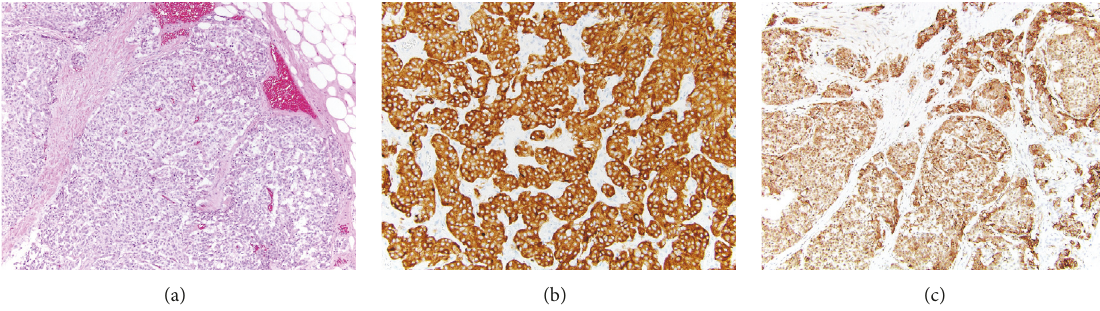
Figure 3: Representative photomicrographs of the well-differentiated neuroendocrine tumor component. (a) H&E section shows the nested pattern of the well-differentiated neuroendocrine cells ( × 10) with invasion into the hilar fat; (b) synaptophysin ( × 20) and (c) chromogranin ( × 10) are diffusely